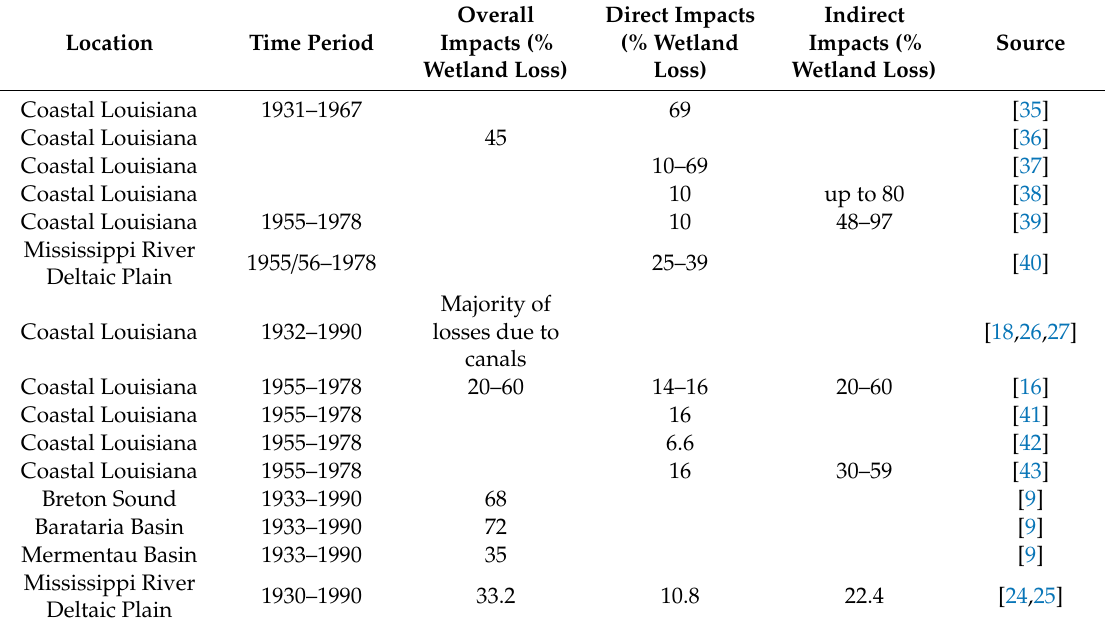
Table 1. Estimates of the percentage of wetland loss caused by all oil and gas activities (overall) or by direct or indirect impacts of oil and gas activities.